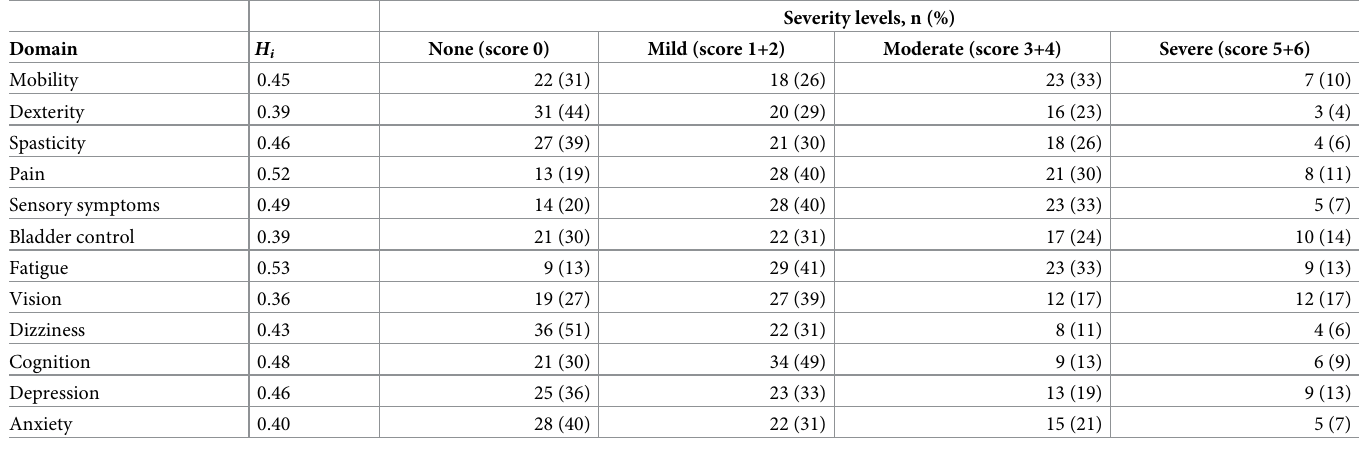
Table 2. Psychometric characteristics of the